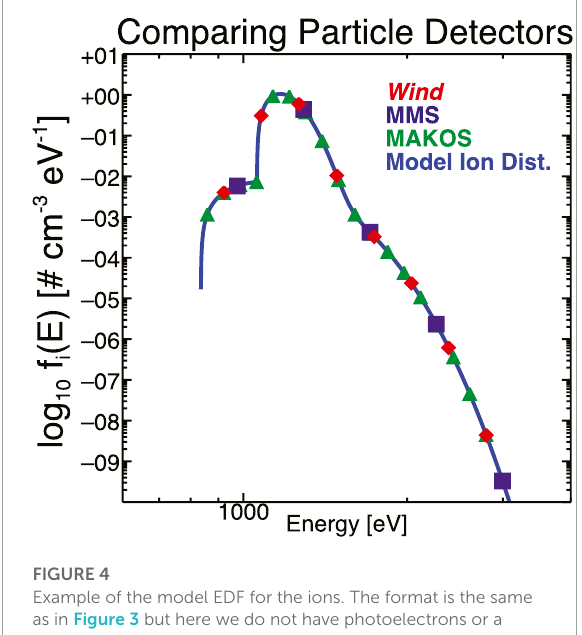
FIGURE 4 Example of the model EDF for the ions. The format is the same as in Figure 3 but here we do not have photoelectrons or a vertical line to mark the spacecraft